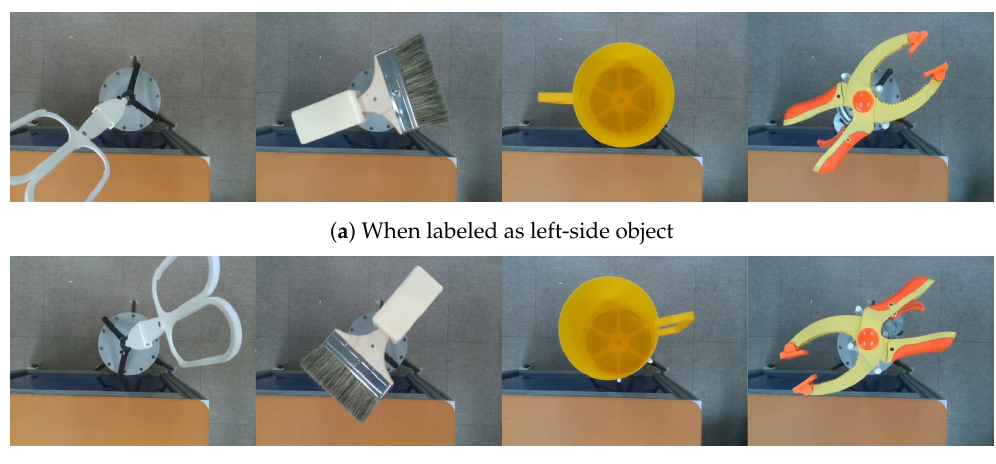
Figure 9. Examples of left-side and right-side objects.